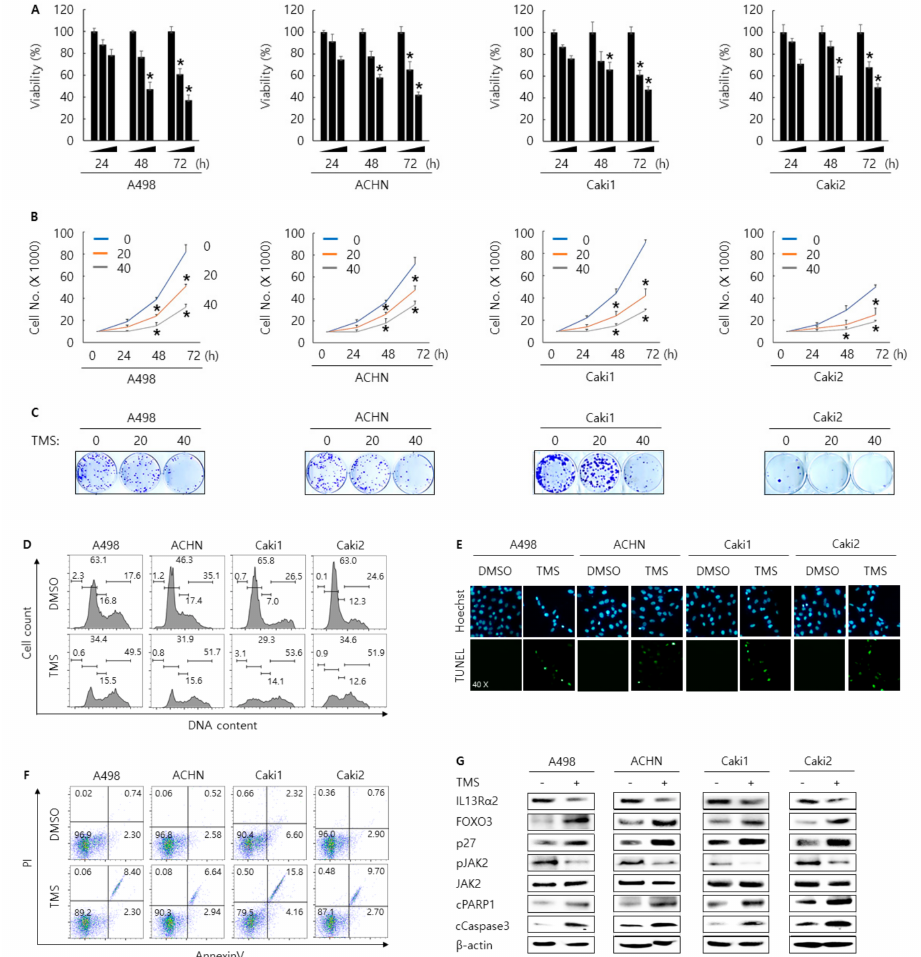
Figure 5. Antiproliferative effect by telmisartan treatment in A498, ACHN, Caki1, and Caki2 cells. Cell viability and proliferation rate were determined by WST-1 ( A ), cell counting assay ( B ) for 24, 48, and 72 h, and Colony formation assay for 14 days ( C ) after treatment of telmisartan (0, 20, and 40 µ M). This result is representative data of at least three independent experiments, and the error bar indicates mean ± standard error (STE). * stands for the P- value < 0.05. Cell cycle arrest for 48 h after treatment of telmisartan (40 µ M) was determined by cell cycle analysis ( D ). Apoptosis for 48 h after treatment of telmisartan (40 µ M) was determined by Annexin V staining analysis ( E ) and Terminal deoxynucleotidyl transferase dUTP nick end labeling (TUNEL) assay ( F ). This result is representative data of at least three independent experiments. ( G ) Western blotting analysis of proteins related to cell cycle arrest and apoptosis for 48 h after treatment of telmisartan (40 µ M). β -actin was used for a gel-loading